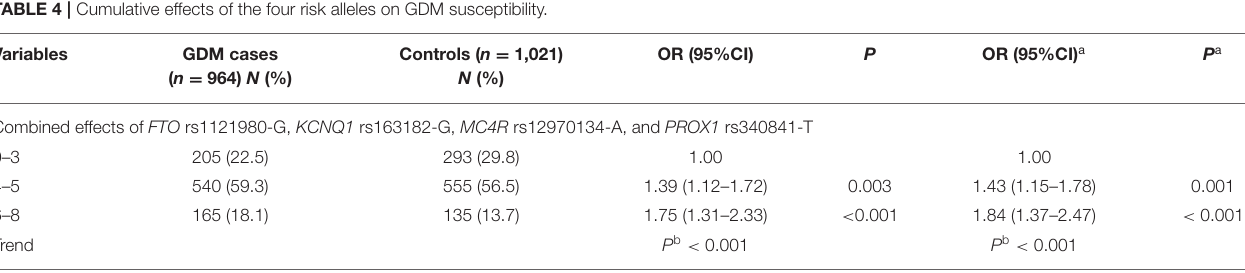
TABLE 4 | Cumulative effects of the four risk alleles on GDM